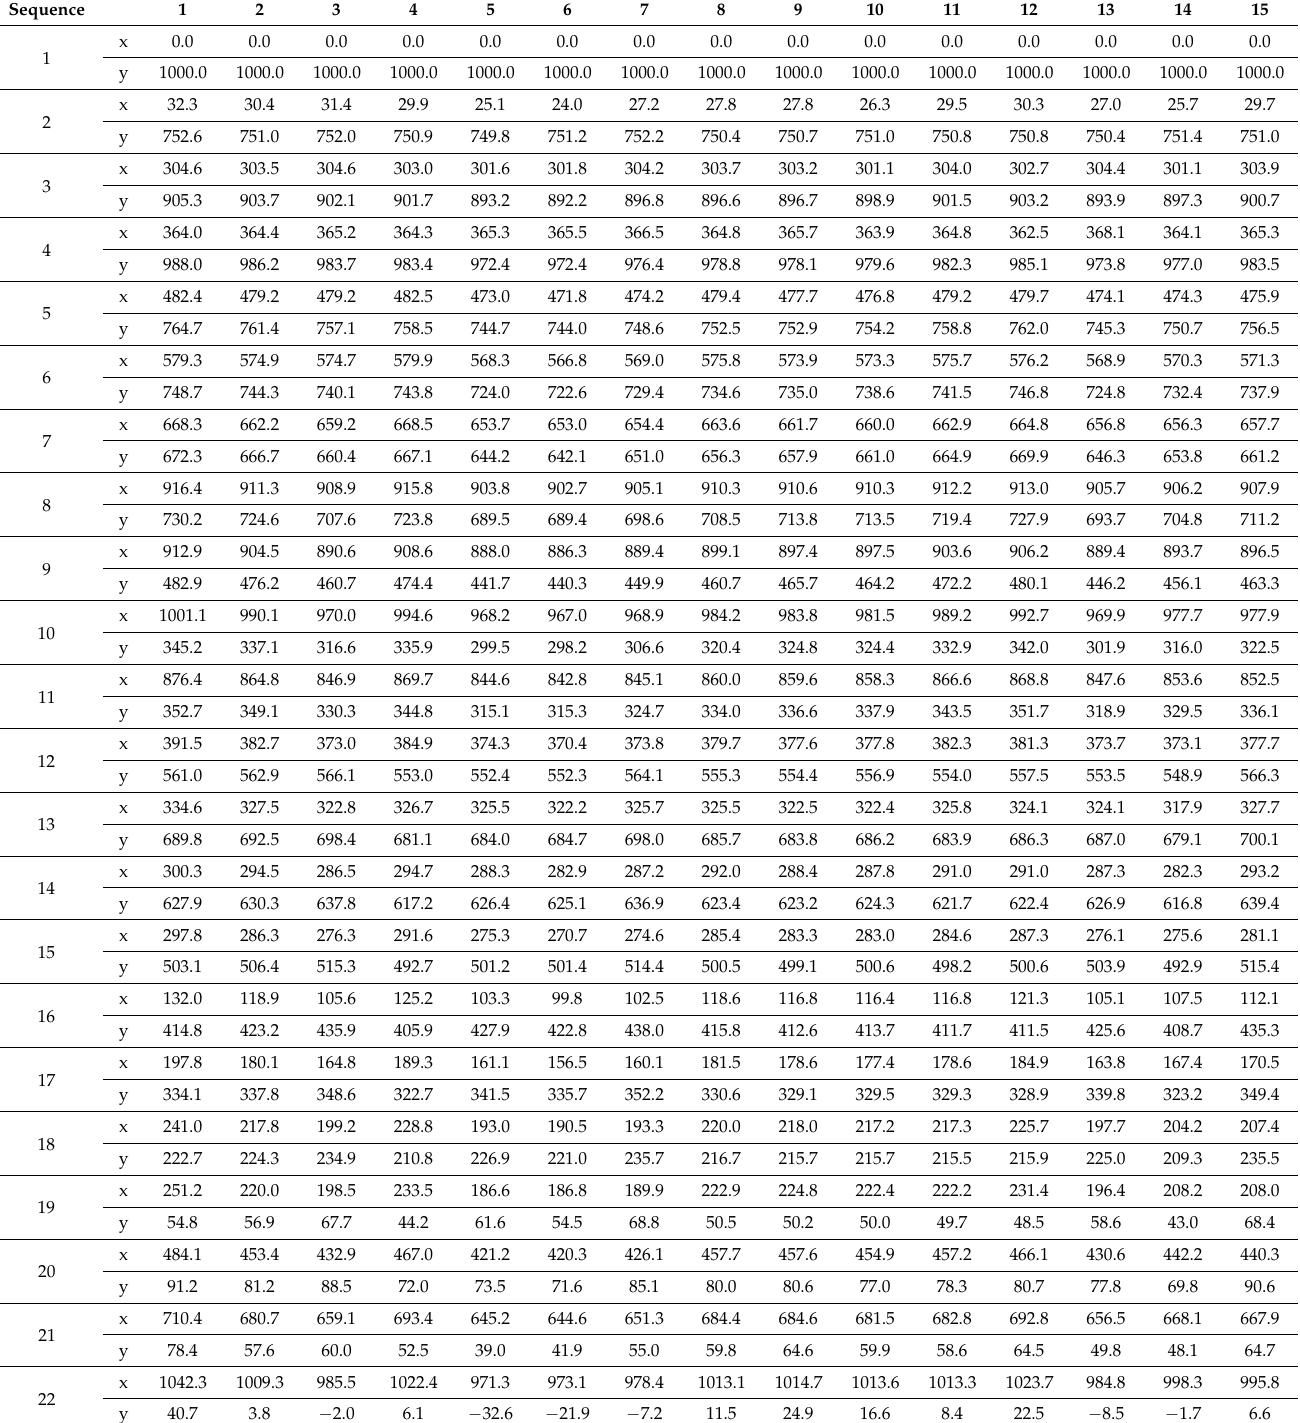
Table A10. Experiment data when moving along the path with the shortest length. The movement commands are compensated